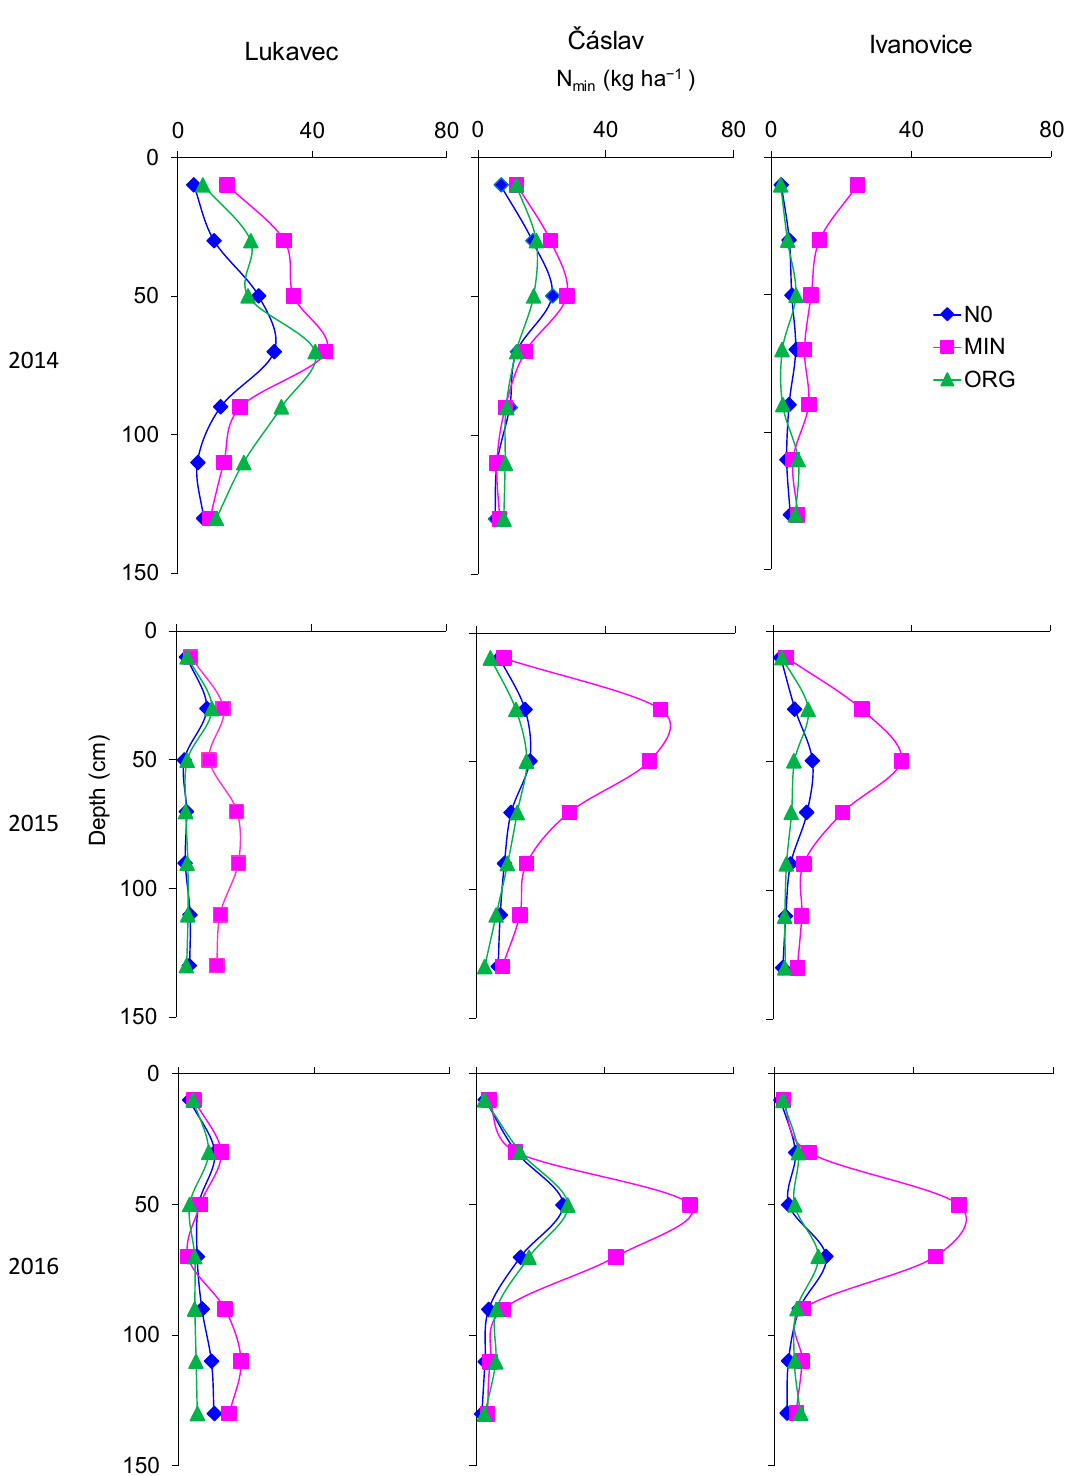
Figure A1. Distribution of the mineral nitrogen content (N min ) in soil layers 0–10, 10–30, 30–50, 50–70, 70–90, 90–110, and 110–130 cm in early spring at the start of plant regeneration.